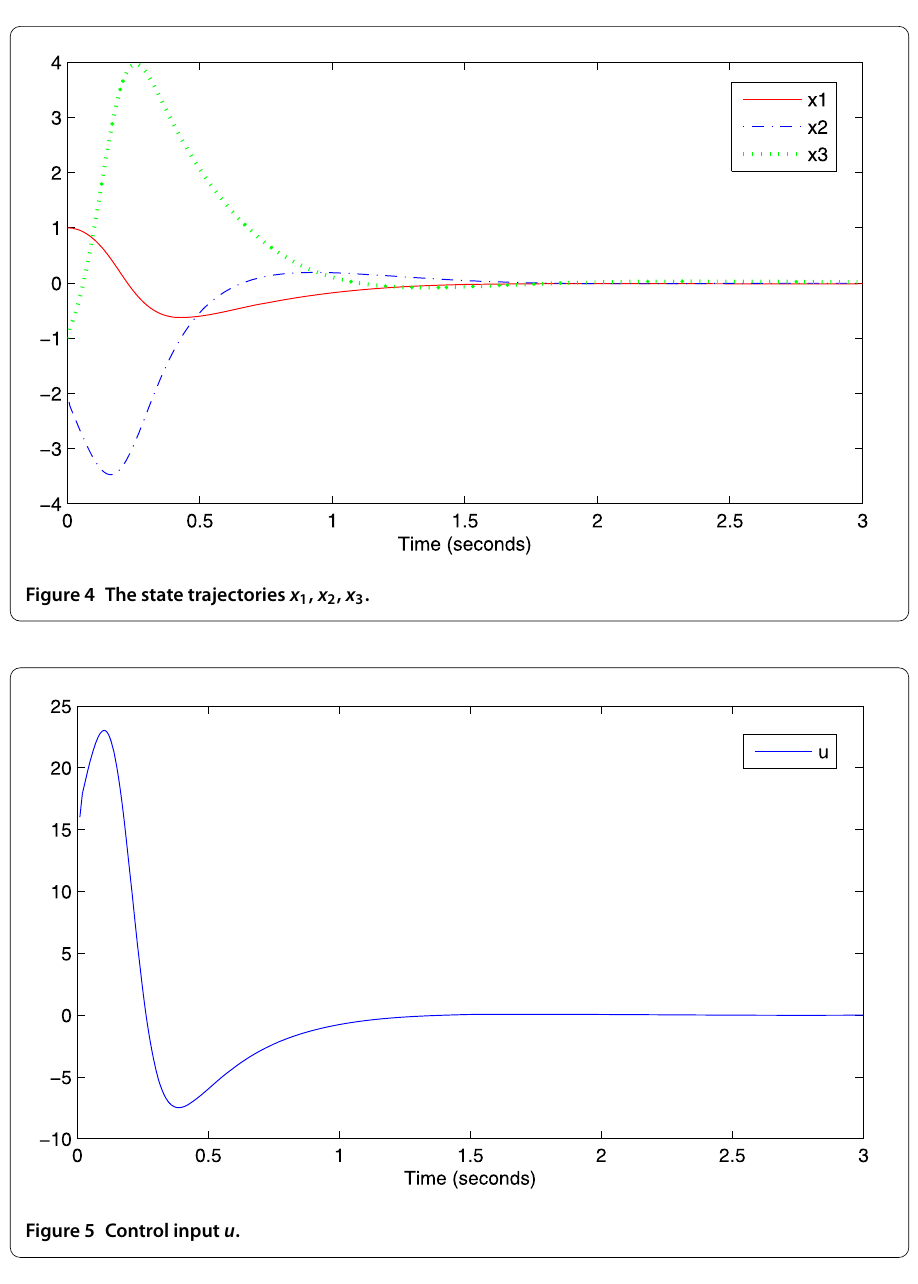
Figure 5 Control input u